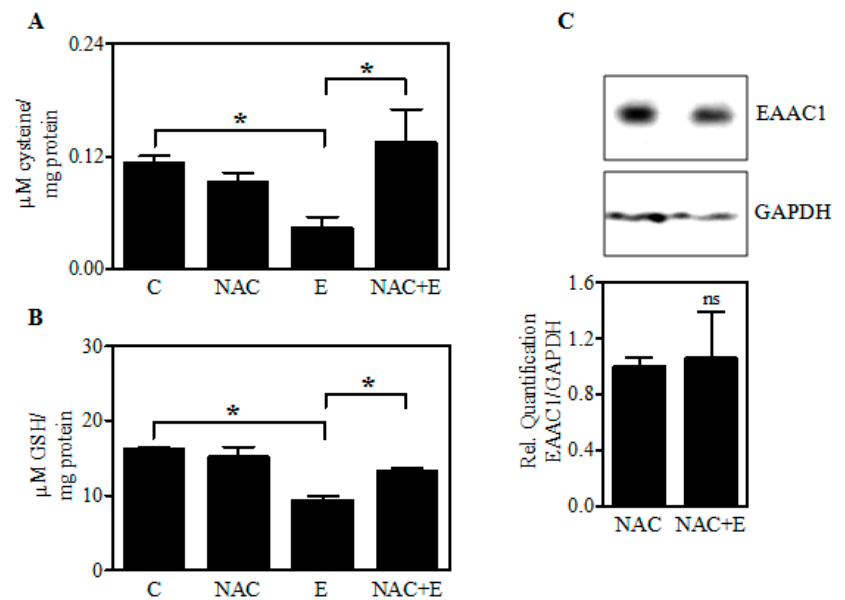
Figure 7. Effect of in utero N -acetylcysteine (NAC) pretreatment on the levels of EAAC1 protein, Cys, and GSH content. Pregnant rats (Sprague-Dawley) at embryonic day 17 were administered NAC (100 mg/kg) 1 h prior to the 1st dose of E. In total, 5 doses of E (3.5 g/kg b.wt.) or isocaloric dextrose were administered by gastric intubation at 12-h intervals. At embryonic day 19 brain cortex from embryos were dissected and processed for HPLC-based determination of Cys concentration ( n = 3) ( A ); GSH content ( n = 3) ( B ); Expression of EAAC1 protein in fetal brain cortices by immunoblotting (top panel) and ImageJ quantification of EAAC1 normalized to GAPDH bands (bottom panel ( n = 3) ( C ). Values represent the mean ± SEM. * p < 0.05 was considered significant for ethanol alone; ns—not significant versus NAC alone treatment.